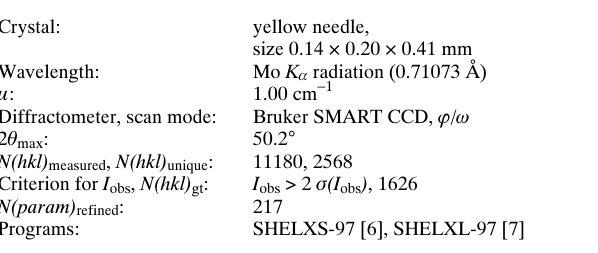
Table 1. Datacollection and